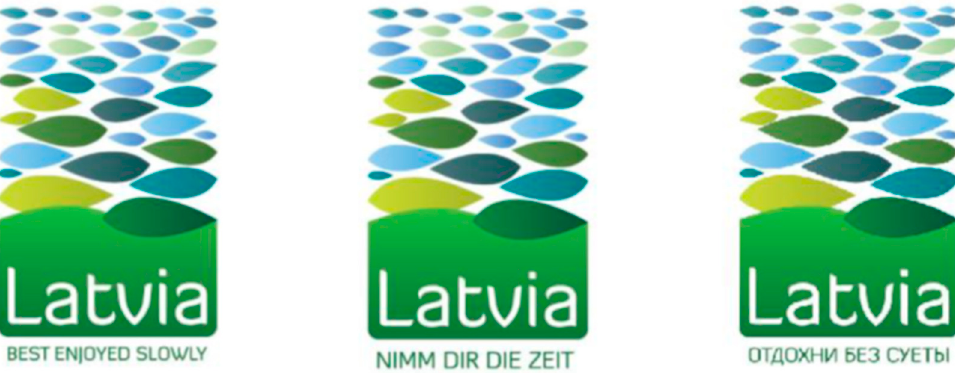
Figure 2. “Latvian tourist brand and slogan in English, German, and Russian” (Serdane 2017, p. 7).